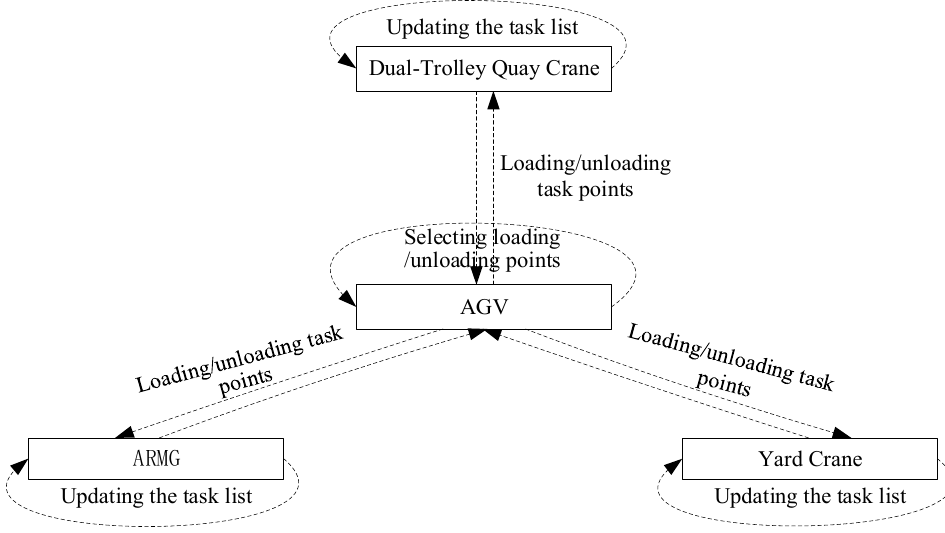
Figure 2. Constraint relationship between ARGC, AGV, AQC, and YC in the rail-in-port model.